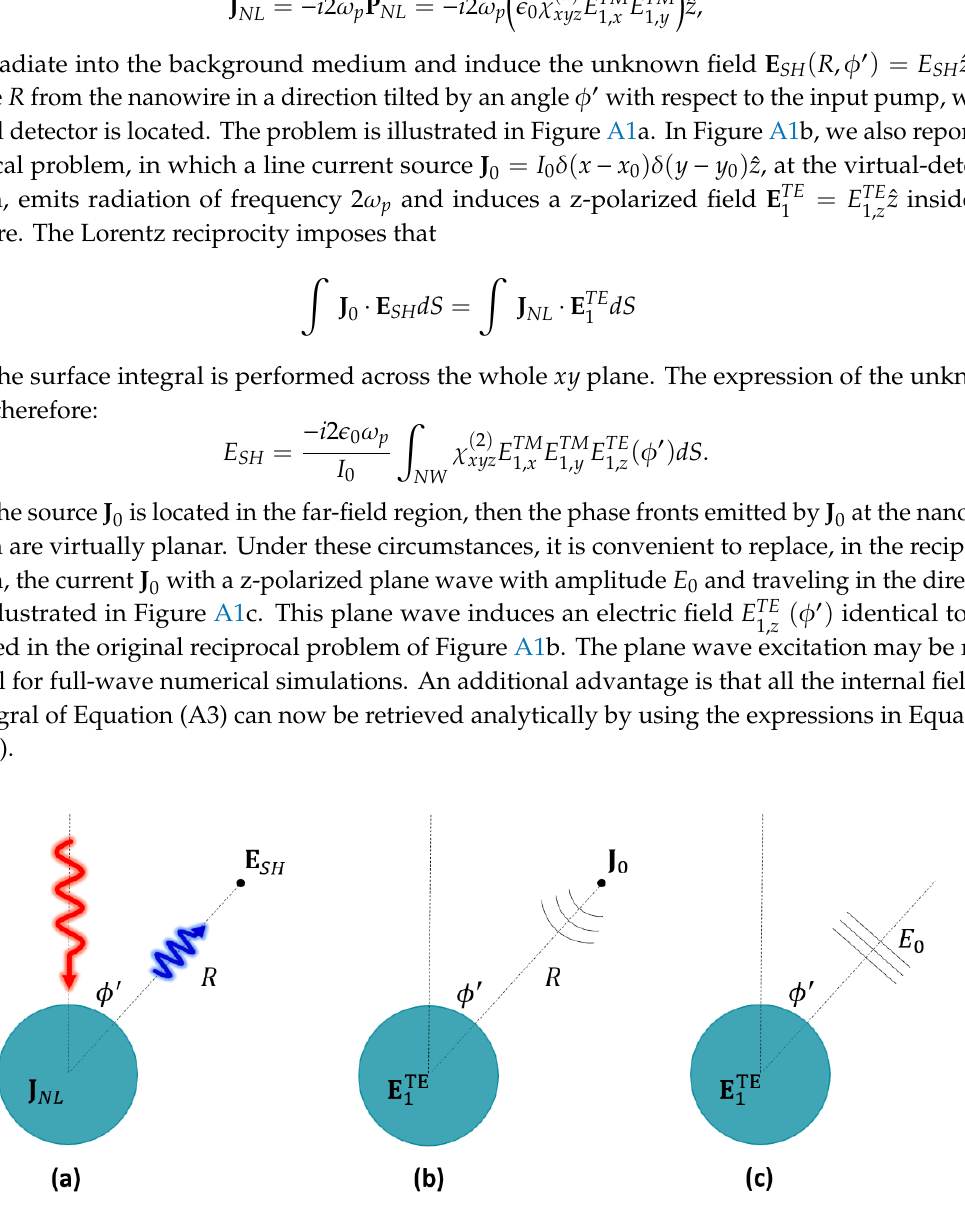
Figure A1. ( a ) SH scattering problem, with a volume current distribution J NL inside the nanowire radiating into the background medium and inducing a field E SH on a detector located in a point in the far-field. ( b ) Reciprocal scattering problem, with a radiating line current source located at the detector point that induces a field E TE inside the nanowire. ( c ) The equivalent of ( b ) with a plane wave source instead of a line current (the approximation is valid if k SH R (cid:29) 1 ).